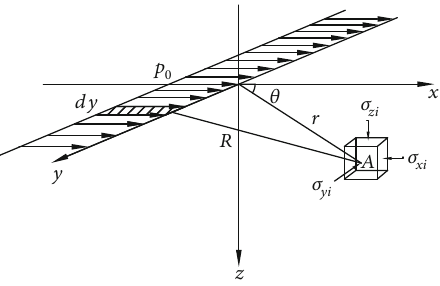
Figure 2: Superimposed stress of soil underlying the anchor beam induced by a horizontal line